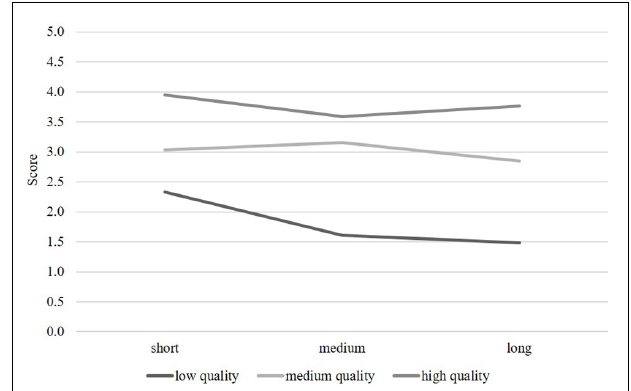
FIGURE 1 | Visualization of the interaction between text length and text